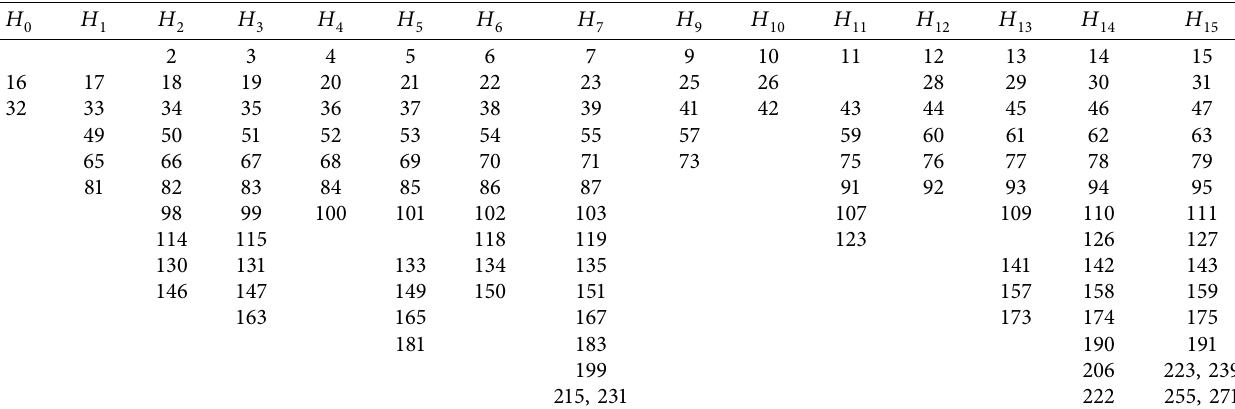
Figure 7: The graphs H � 2, 3, 4, 5, 6, 7 and 11, 12, 13, 14, k , for k Table 4: HM values which do not exist. 2